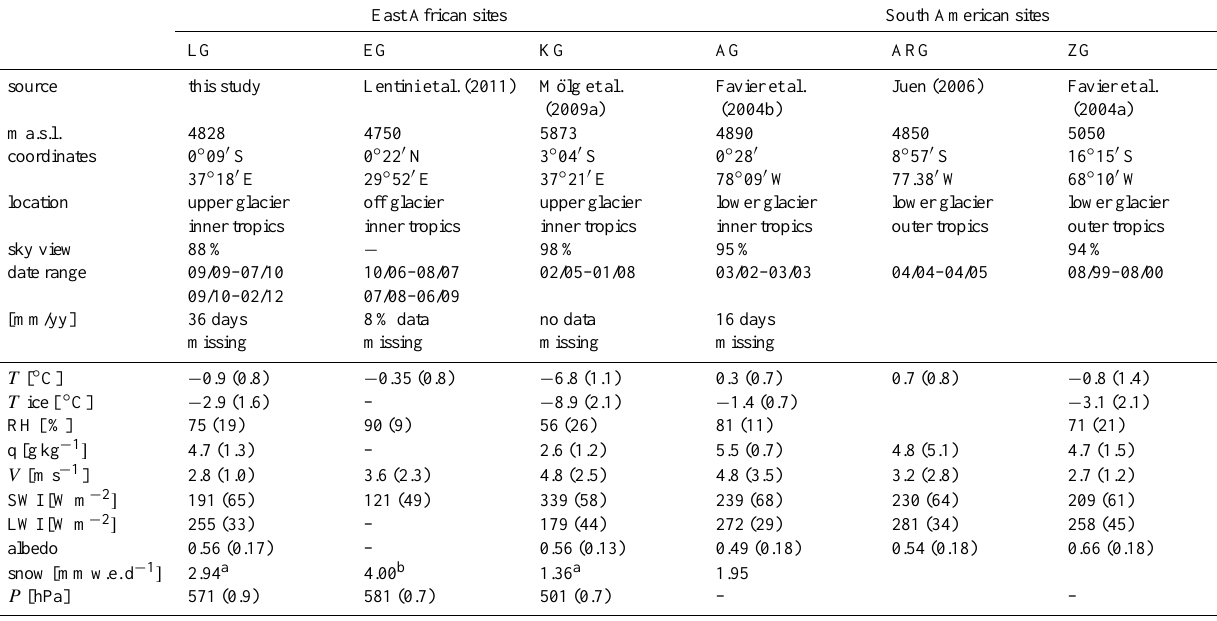
Table 2. Comparison of the AWS station locations and daily mean (standard deviation) conditions measured at each site over the respective period of published data. ARG and ZG are glaciers in the outer